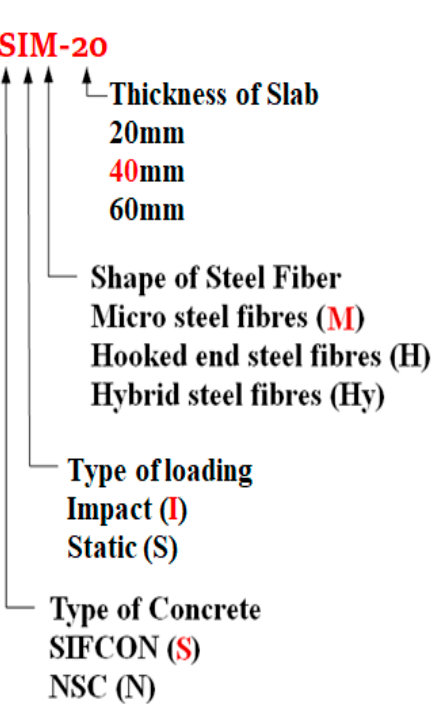
Figure 1. Samples coding method adopted in this research.